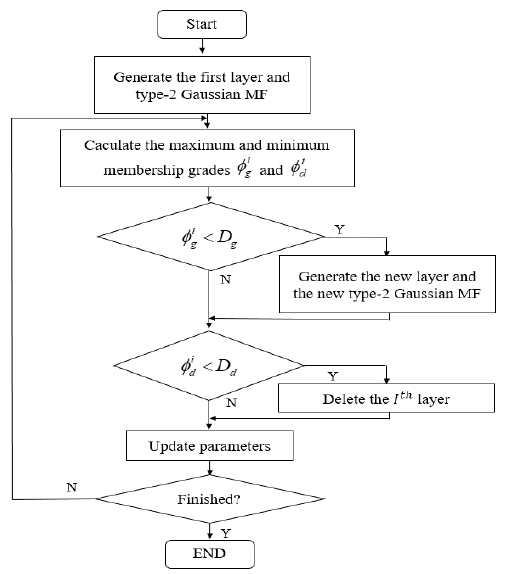
Figure 5. Self-evolving flowchart for RIT2PC.